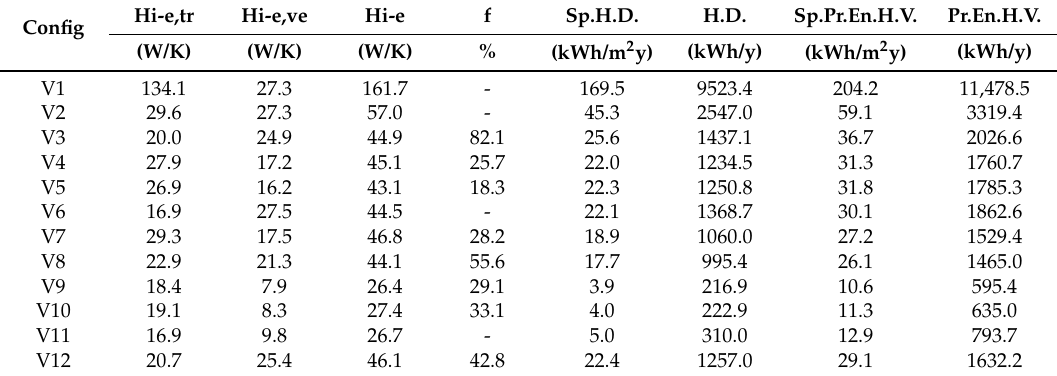
Table 2. Energy performance of the different verandas